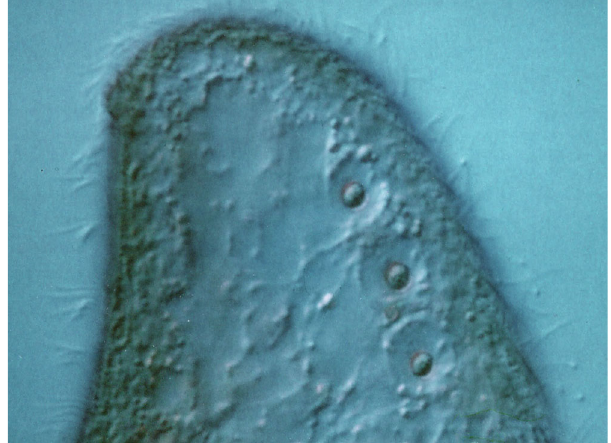
Fig. 2 Müller organelles (3) acting as cellular gravisensors in L. striatus , containing a barium sulfate granulum (3 µm diameter) fi xed to a microtubular structure (courtesy N.